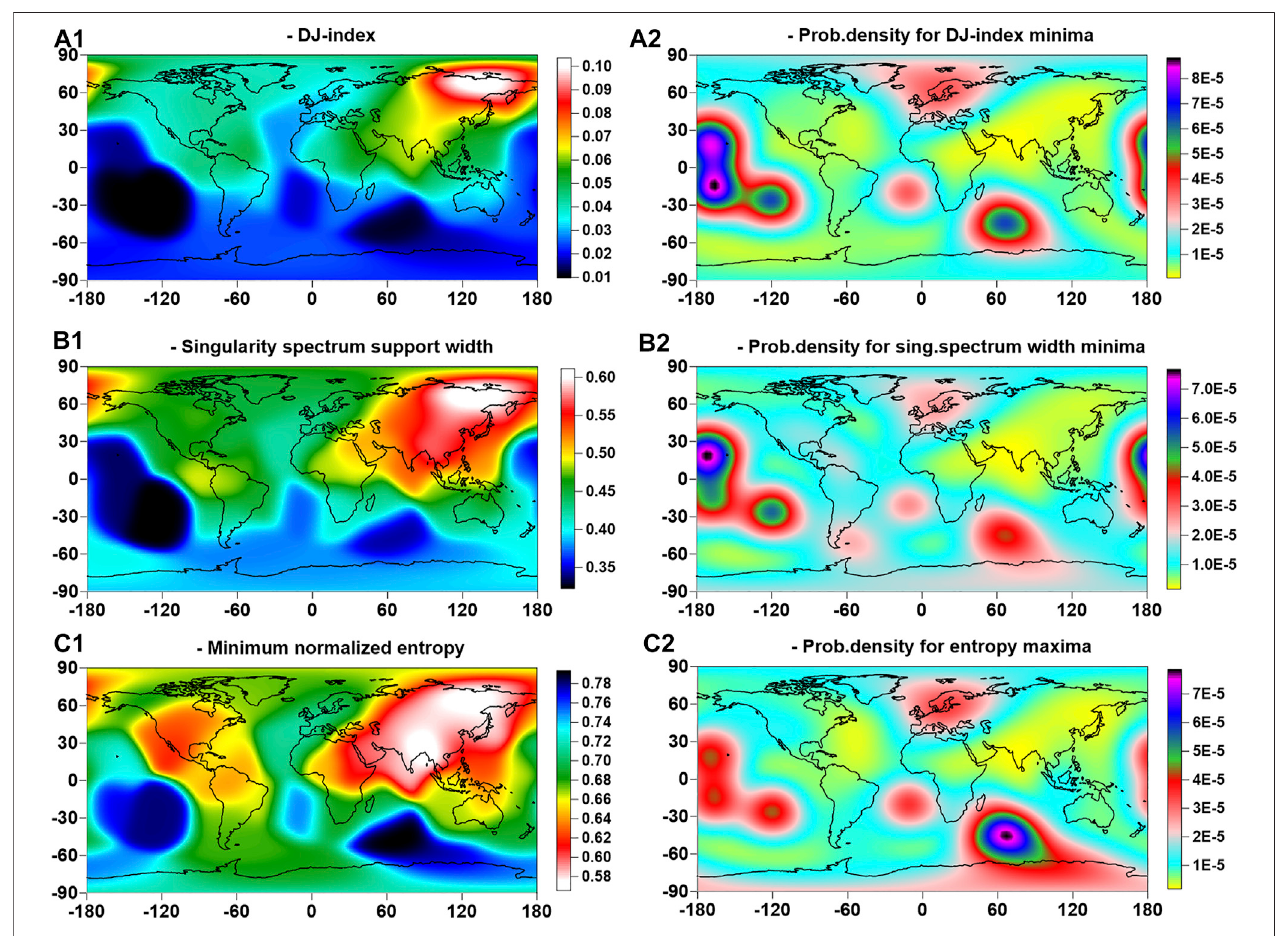
FIGURE 4 | On the left — (A1 – C1) — ` averaged maps of the distribution of seismic noise parameters γ , Δα and En , obtained by interpolation of values from the network of reference points using a Gaussian kernel with an averaging window radius of 15 ° ; on the right — (A2 – C2) — probability density maps of the distribution of extreme values (minima for γ and Δα , maxima for En ), also obtained using a Gaussian kernel with a smoothing radius of 15 ° .